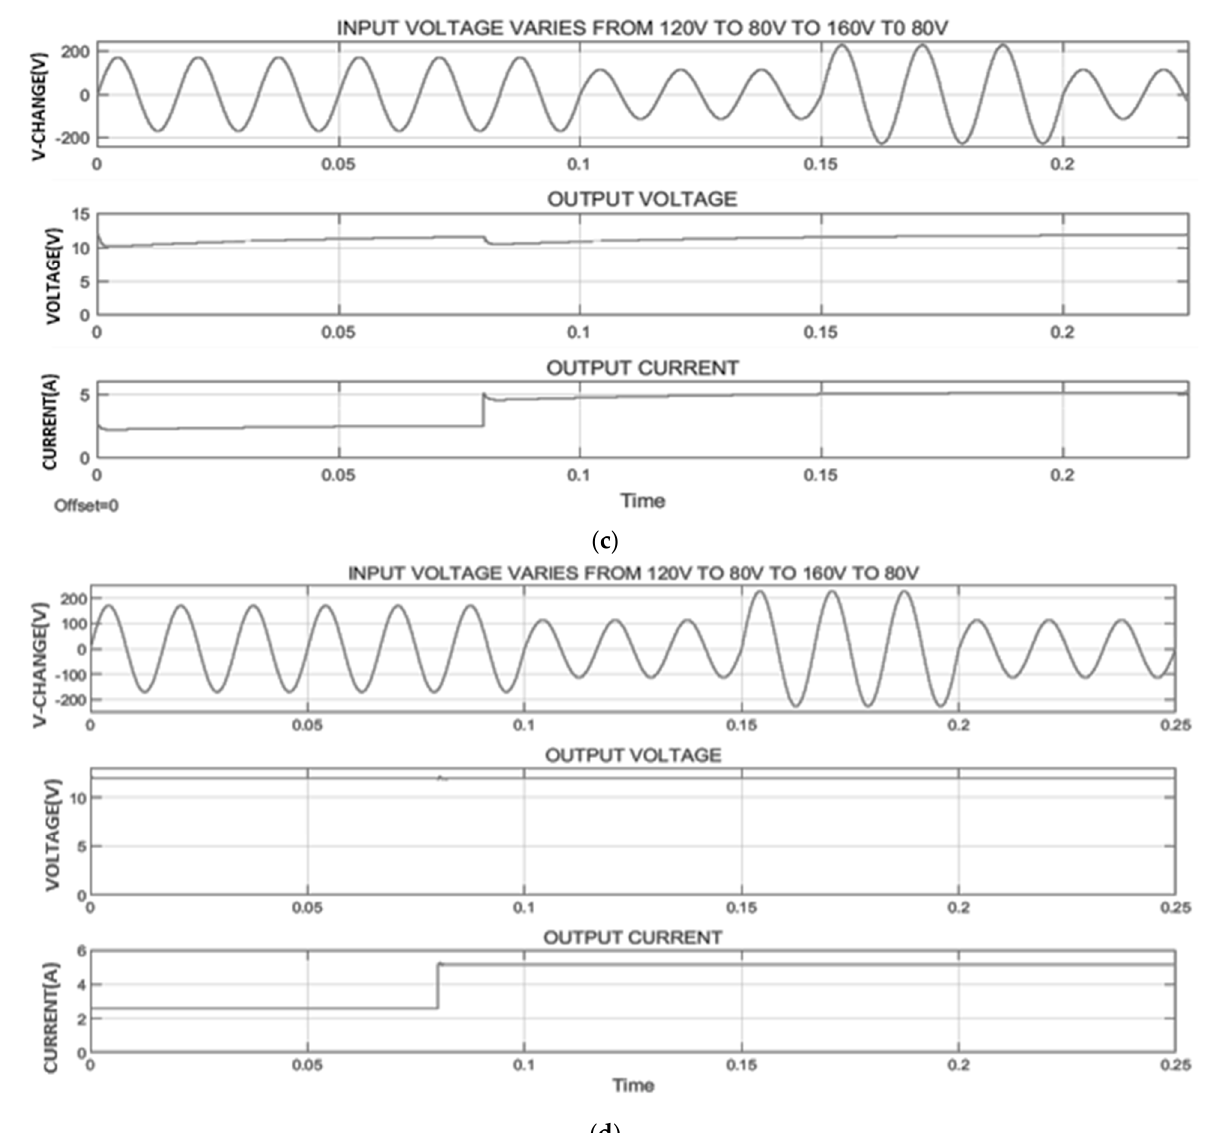
Figure 24. OPAL-RT simulator data validation. ( a ) OPAL-RT open-loop simulation validation; ( b ) OPAL-RT closed-loop three-level cascaded validation; ( c ) OPAL-RT fuzzy logic controller simulation validation; ( d ) OPAL-RT neuro-fuzzy simulation validation.